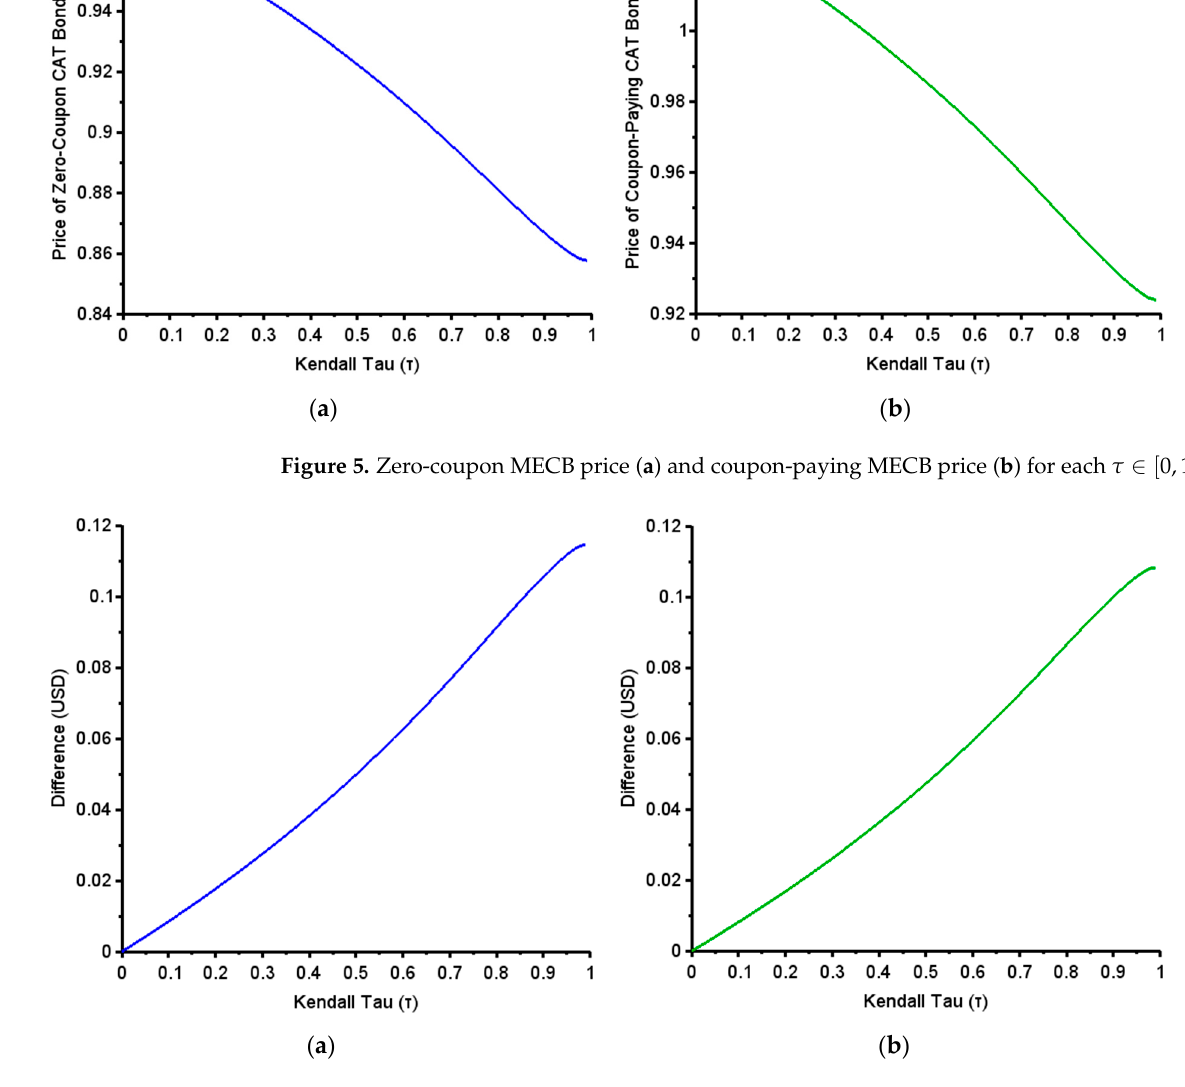
Figure 5. Zero-coupon MECB price ( a ) and coupon-paying MECB price ( b ) for each 𝜏 ∈ (cid:4670)0,1(cid:4667) .